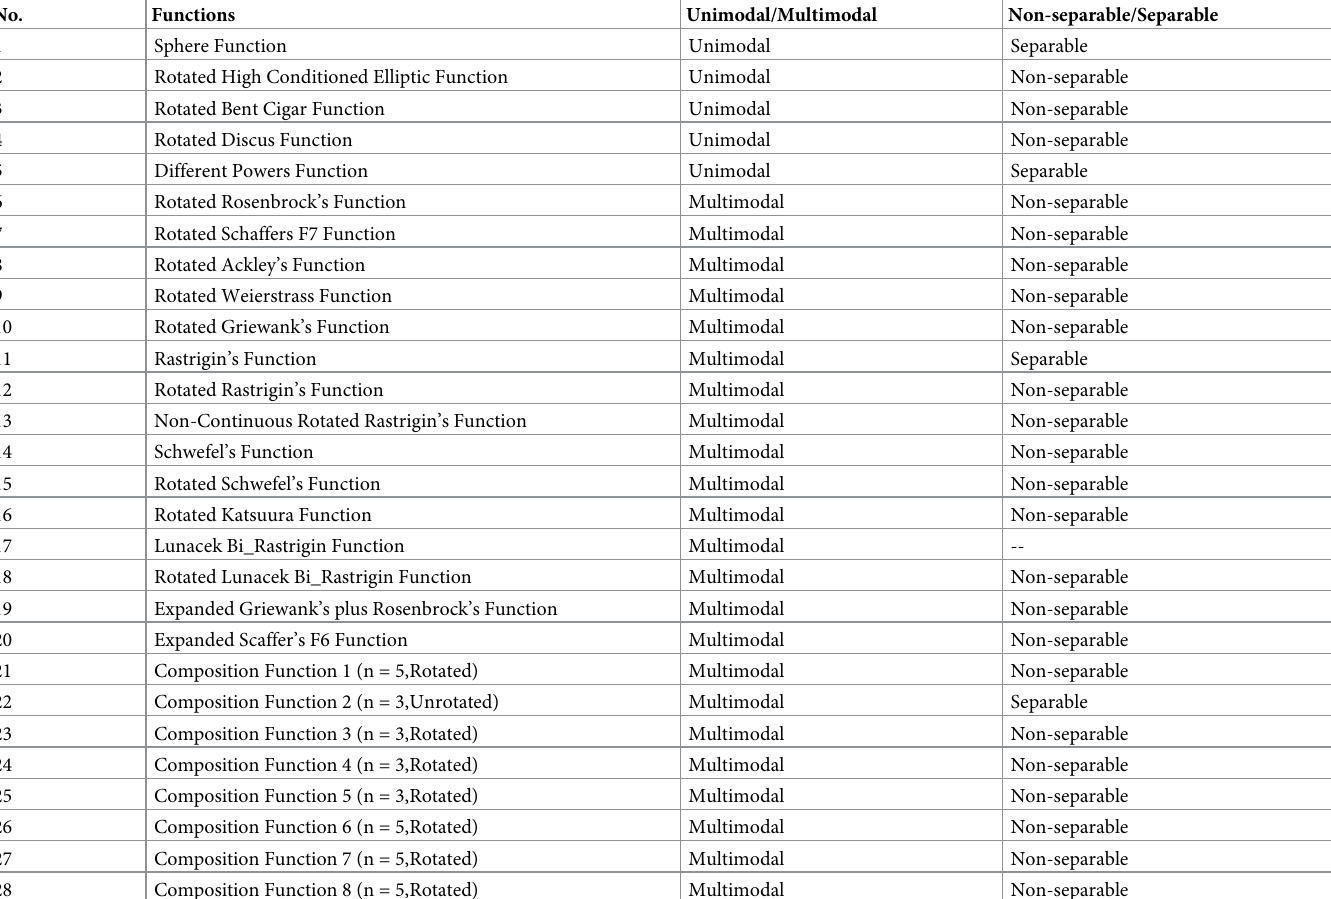
Table 1. Summary of the 28 CEC’13 test